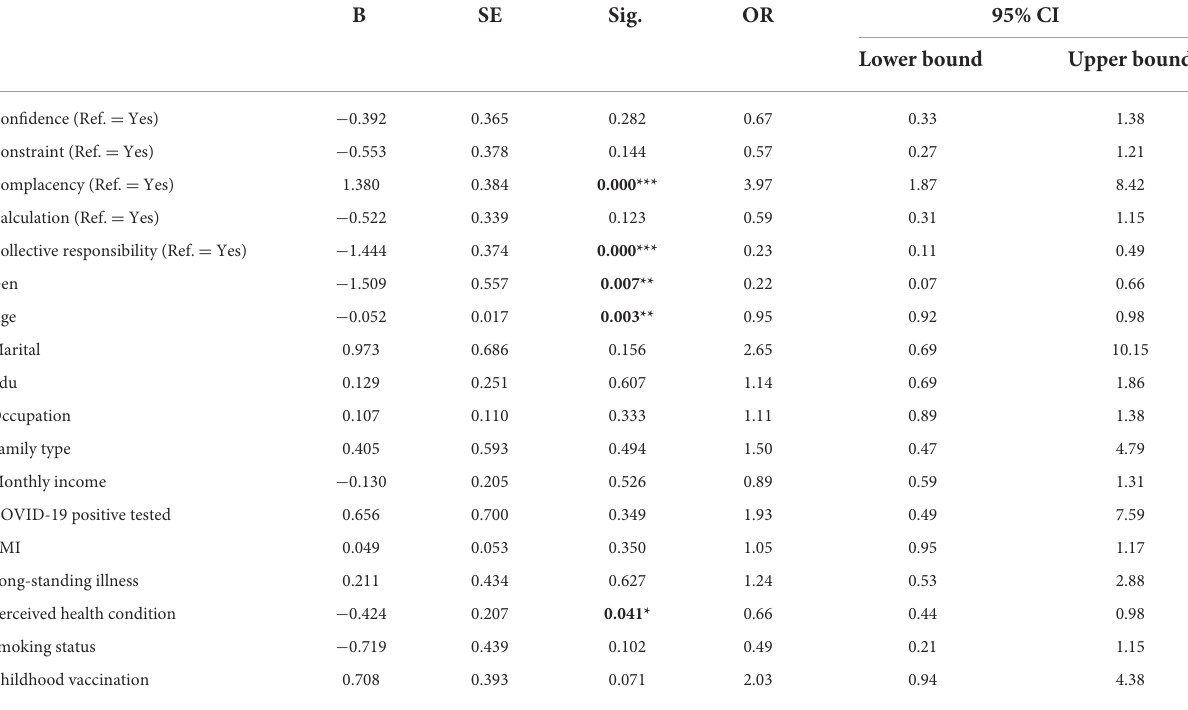
TABLE 4 Multinomial logistic regression results determine the association between 5C domains and willingness to accept the COVID-19 vaccine.